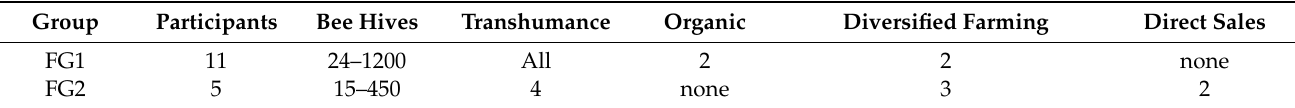
Table 1. Main farm characteristics and management practices adopted by the participants of the two focus group discussions (FGDs) (n). Group